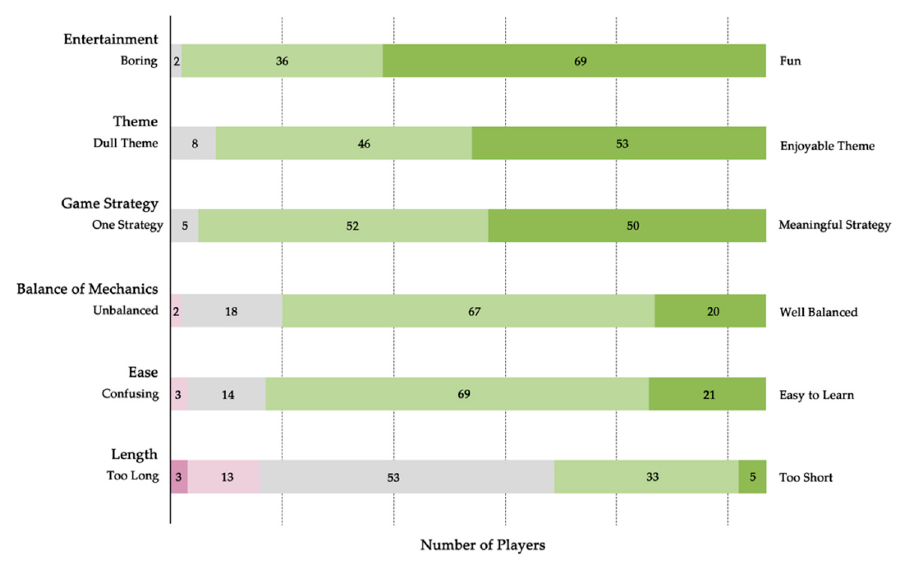
Figure 2. Feedback on the SG sessions.